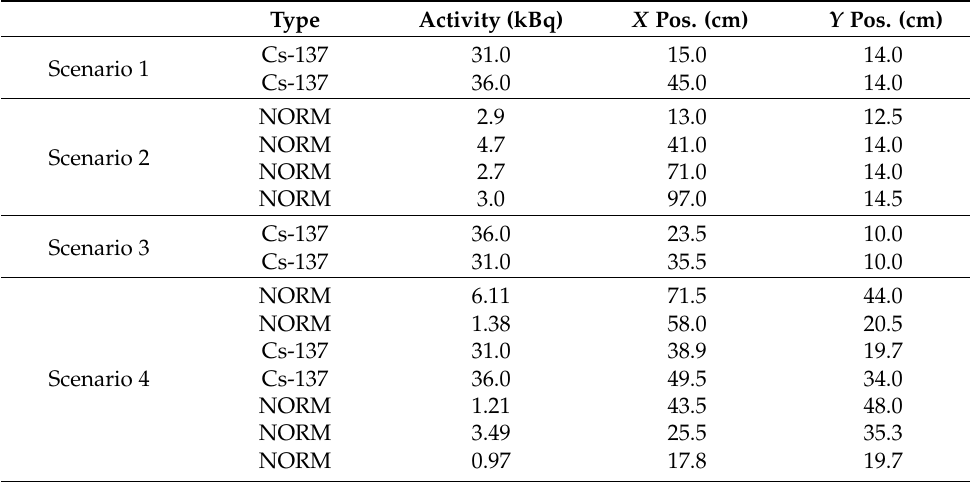
Table 2. Puck types and placements relative to the robot base